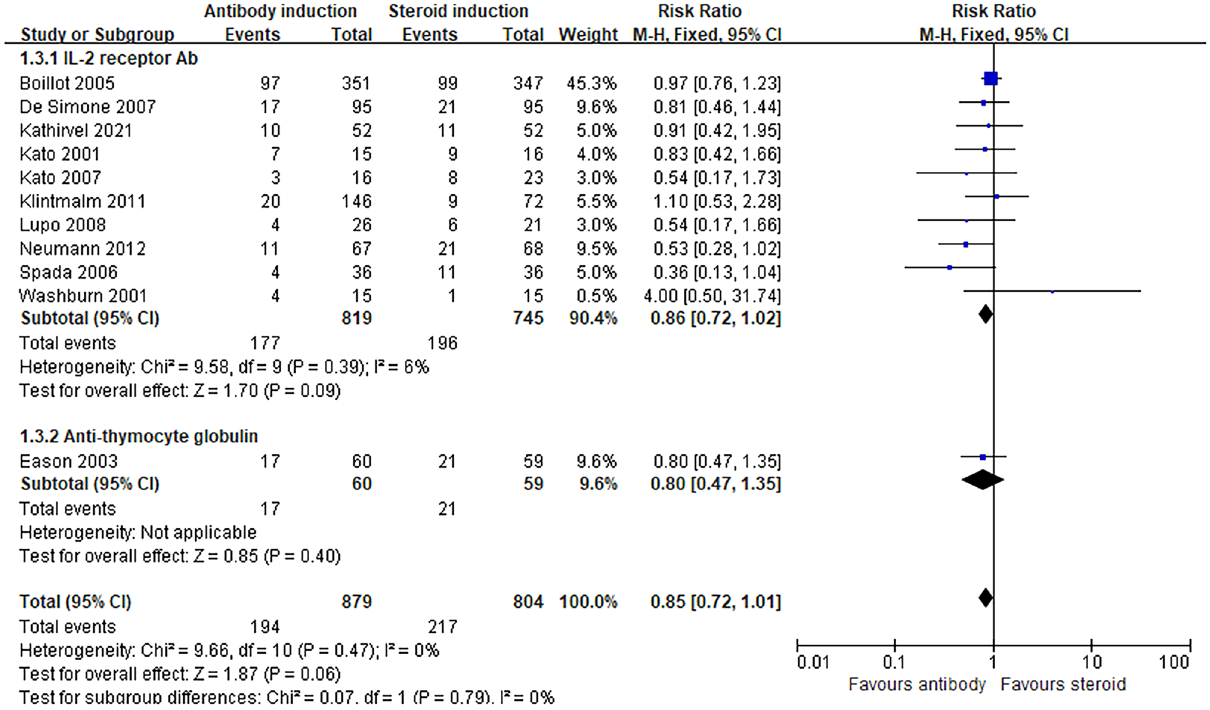
Figure 1. Forest plot of comparison between antibody induction versus corticosteroid induction: Acute